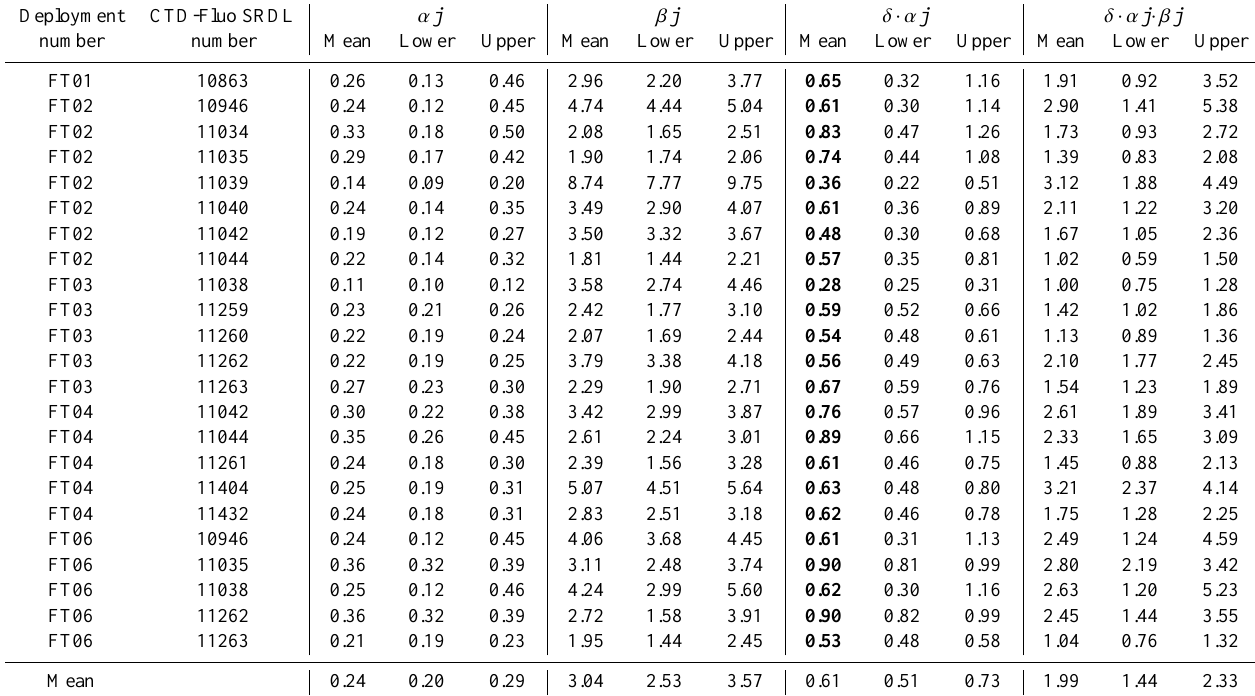
Table 2. Correction coe ffi cient calculated for each fluorometer tag (see methods for details). The bold values refer to the correction coe ffi cient applied to the corresponding fluorometer tag, to estimate [chl a